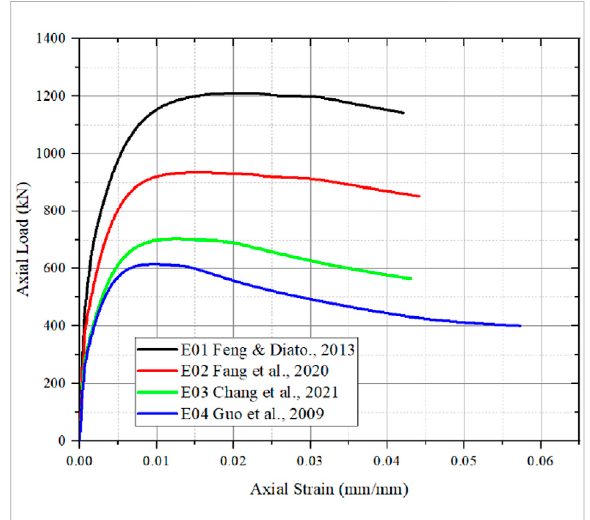
FIGURE 1 Axial stress and axial strain from (Feng and Ditao, 2013;